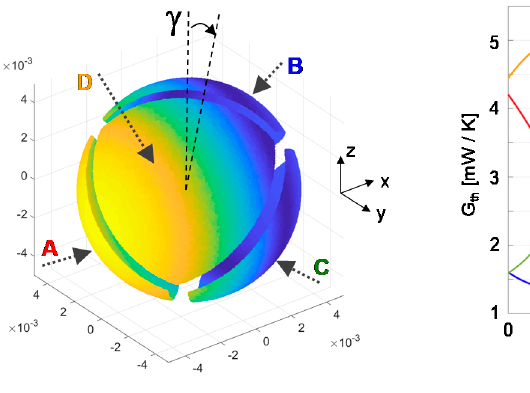
Figure 24. Evolution with the yaw angle of the average convective heat transfer coefficient of each sector of the sphere at Re = 1000 and a small tilt γ = 4.5° along the direction of the B-D groove. These values have been obtained by integration from DNS. The wind direction is parallel to the x -axis. The disposition of the sectors A, B, C and D is the same the one shown